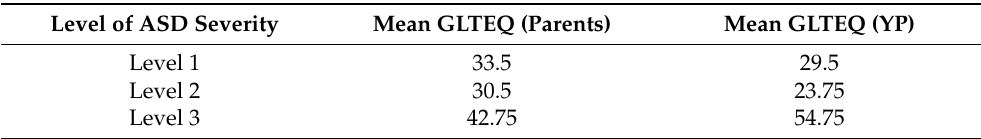
Table 3. Results Showing Mean Godin Leisure-Time Exercise Questionnaire (GLTEQ) Scores Per Level of Autism Spectrum Disorder (ASD) Severity Group.